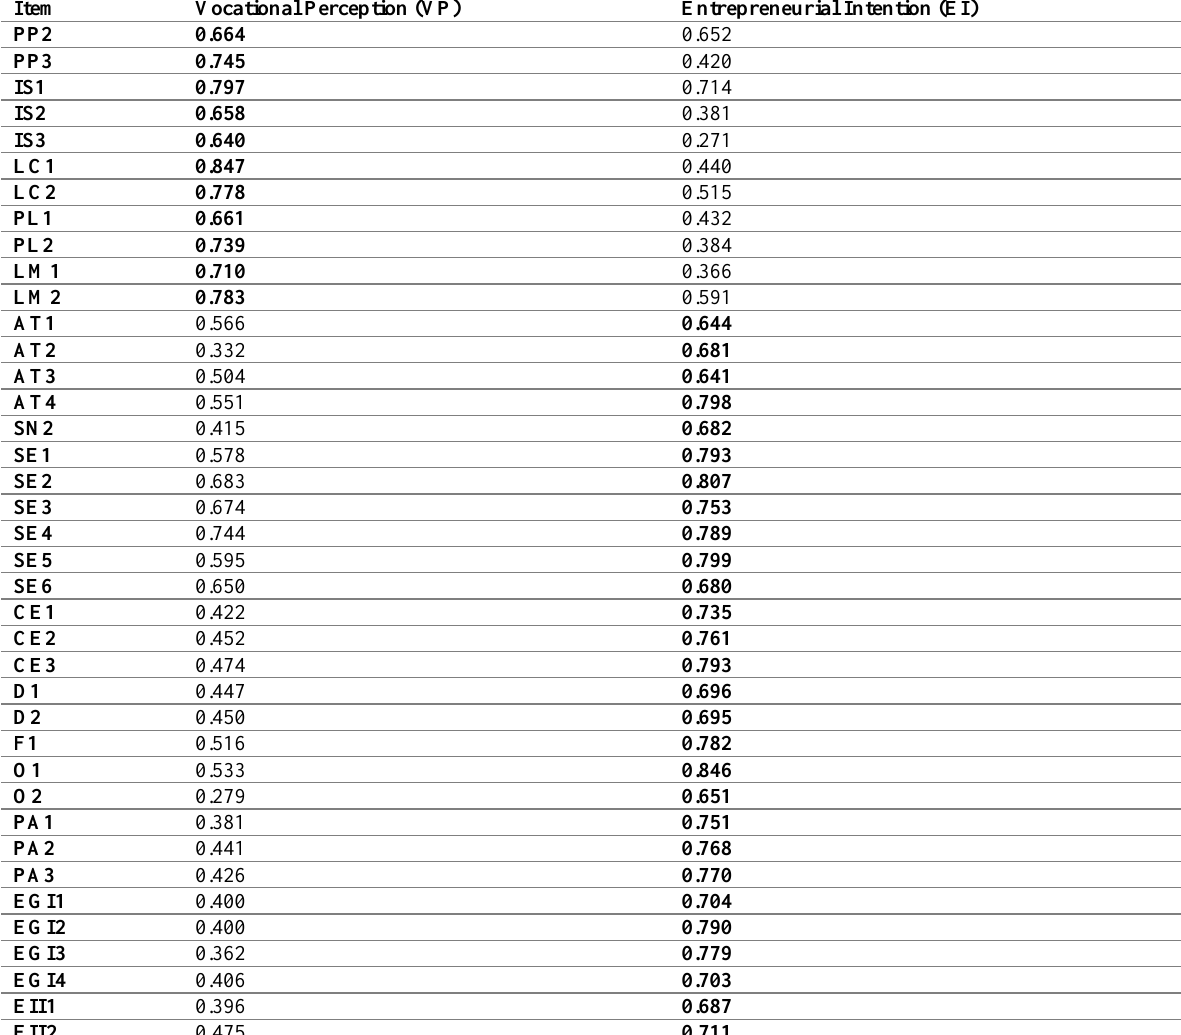
Table 3: Discriminant Validity Test Results